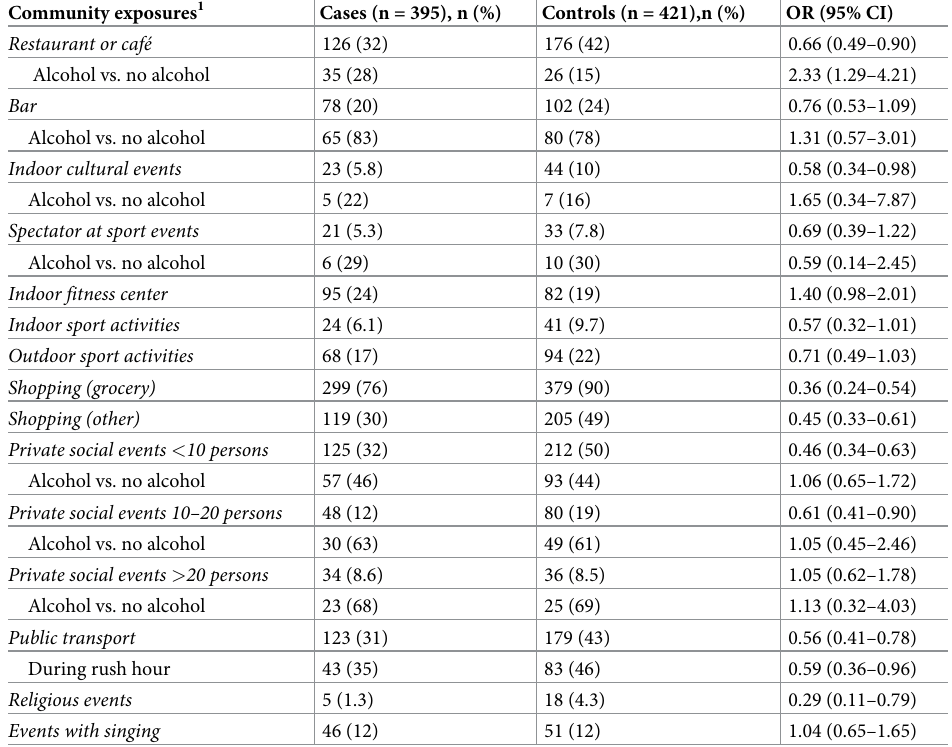
Table 4. Number, proportion and odds ratios related to community exposures without household transmission, Denmark, June 2021. Community exposures 1